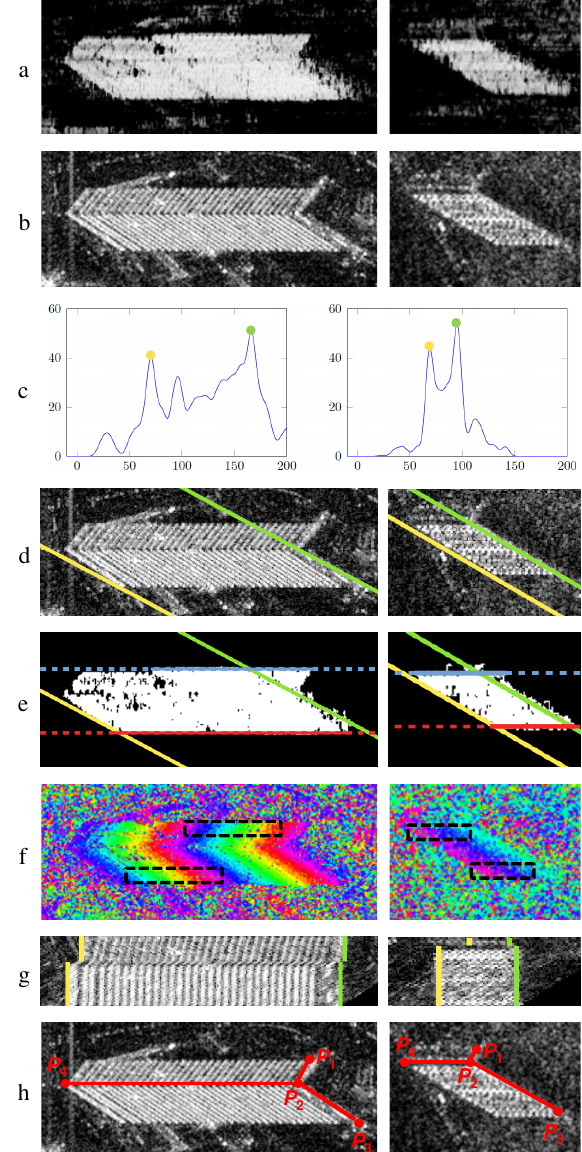
Figure 7: Detector of building shape: – result of ramp detector (a), intensity patch (b), Hough histogram (c), detection of azimuth lines (d), result of line detection (e), analysis of building type (f), input of height extraction (g), and bases of building shape